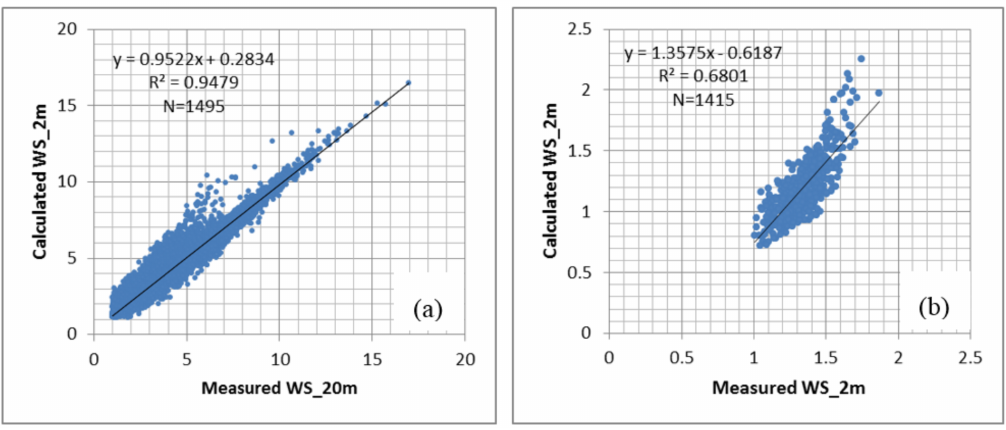
Figure 2. The distribution of scatters at ( a ) Arou site and ( b ) Guantan site between measured wind speed and calculated wind speed with Monin–Obukhov